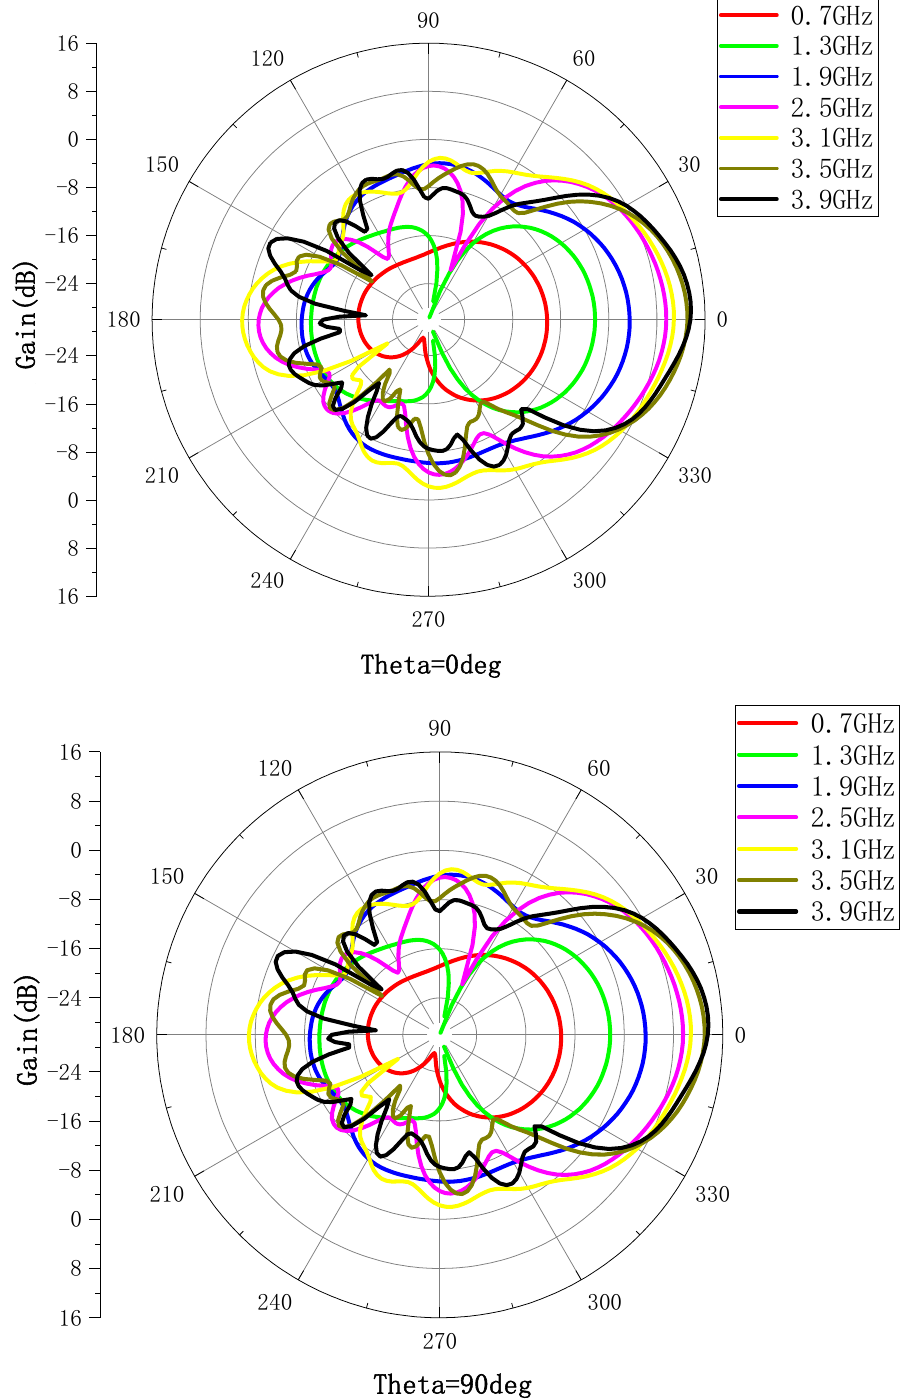
Figure 8. Vivaldi antenna pattern in horizontal plane ( top ) and vertical plane ( bottom ). The radiation efficiency and gain of the antenna are shown in Figures 9 and 10. The radiation efficiency is above 45% at 2 GHz and reaches up to 90% at 3.2 GHz. The peak of the gain of the antenna can reach 13.5